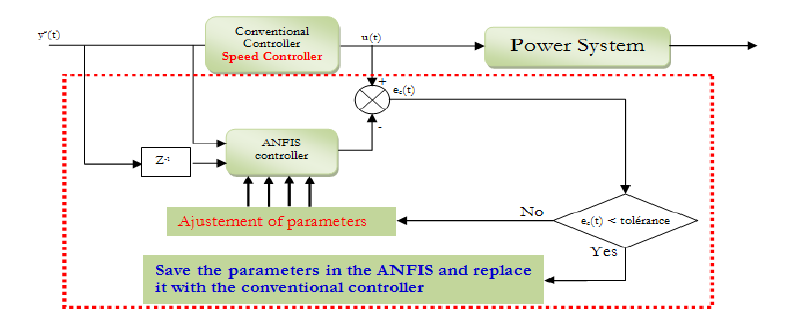
Fig 2 . Flow Chart of the proposed ANFIS controller